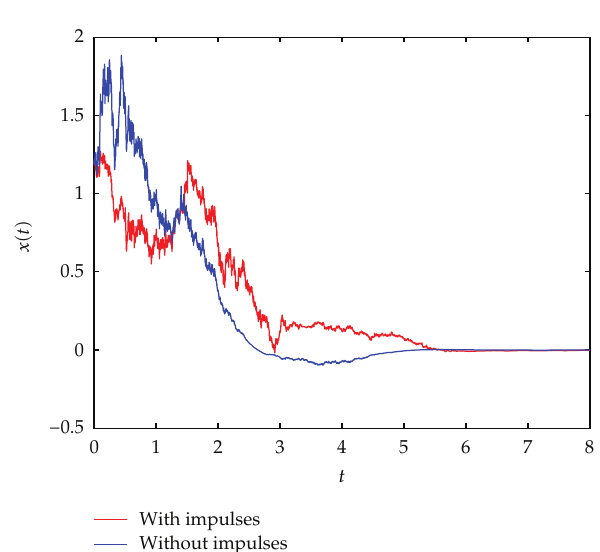
Figure 2: Impulsive disturbance of Example